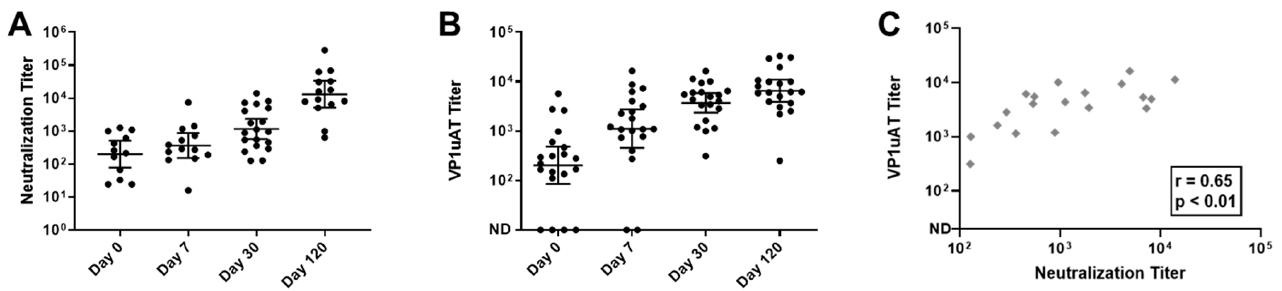
Figure 4. Kinetics of neutralization and VP1uAT ELISA responses to parvovirus B19 infections among children with SCD and TAC. Longitudinal serum samples from hospitalized patients were assayed. ( A ) Parvovirus B19 neutralization titers were defined as the inverse of the highest serum dilutions that reduced viral transcripts by 90%. ( B ) VP1uAT ELISA results. ND = antibodies not detected. Geometric means are shown with 95% confidence intervals. ( C ) VP1uAT and neutralization results on Day 30 are shown with Spearman’s correlation r and p values. Table 2. Kappa coefficient, sensitivity and specificity of VP1uAT ELISA and VLP IgG ELISA with the neutralization assay as the gold standard.